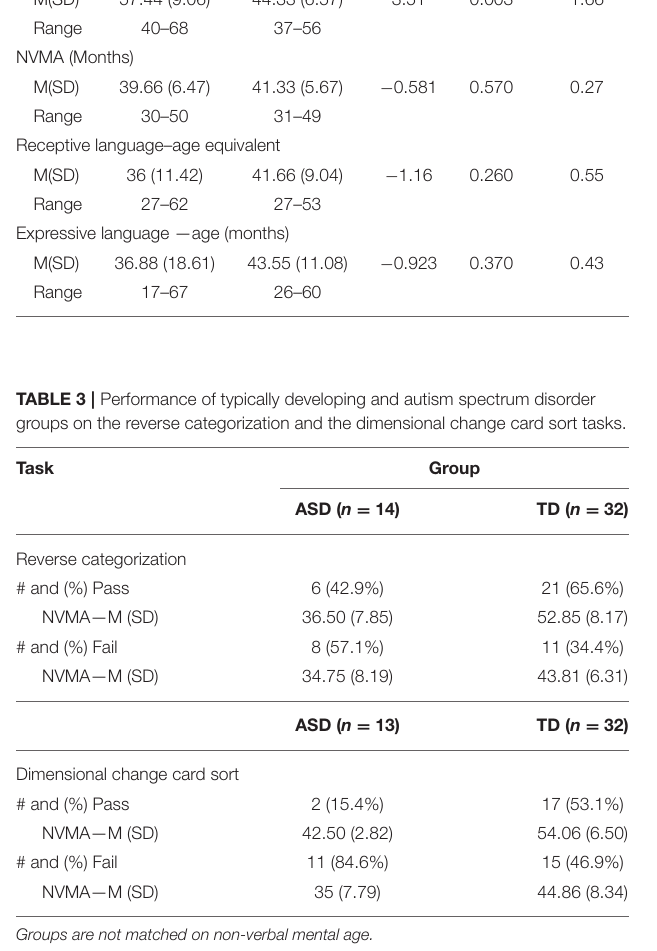
RESULTS Group Differences on the RC and DCCS